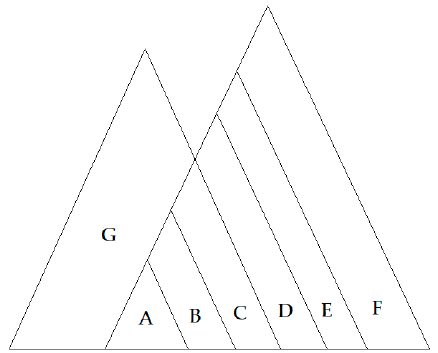
Figure 1. The relationships among some algebraic systems.